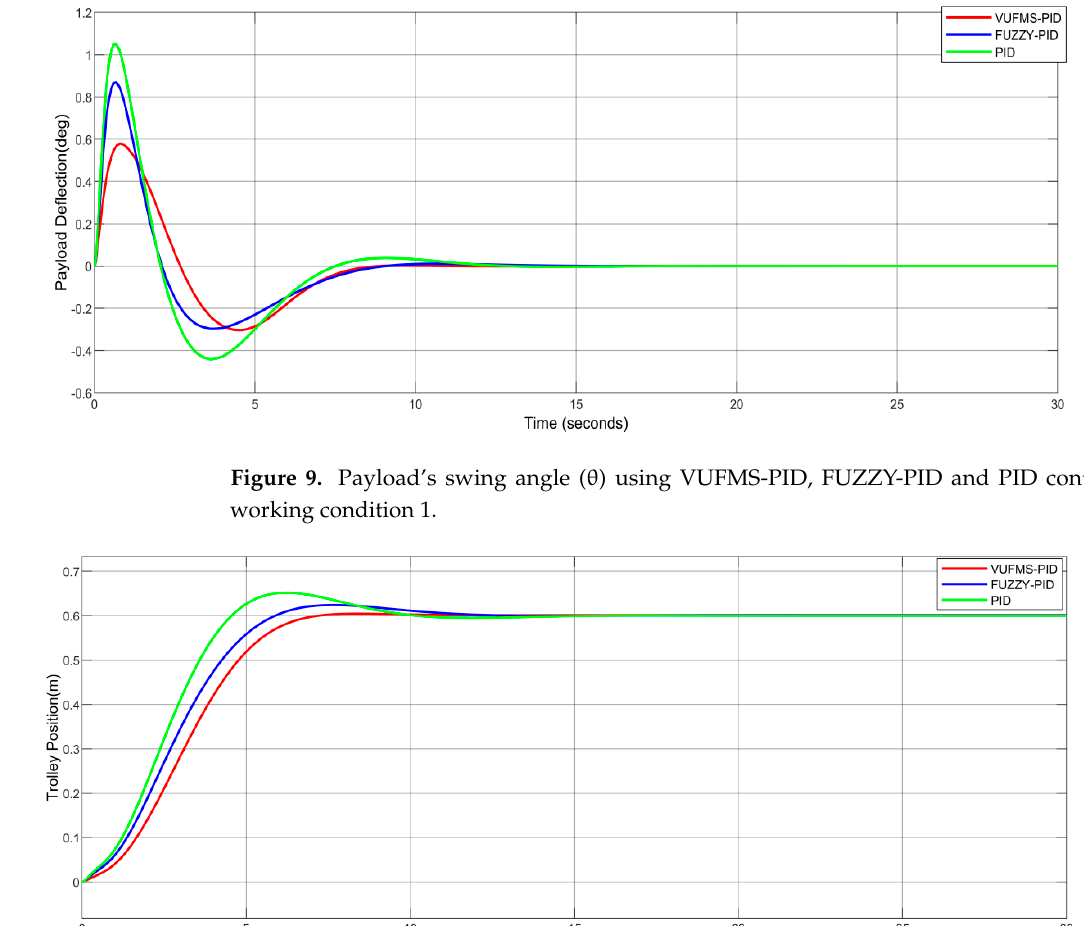
Figure 8. Trolley’s position using VUFMS-PID, FUZZY-PID and PID controller under working condition 1.